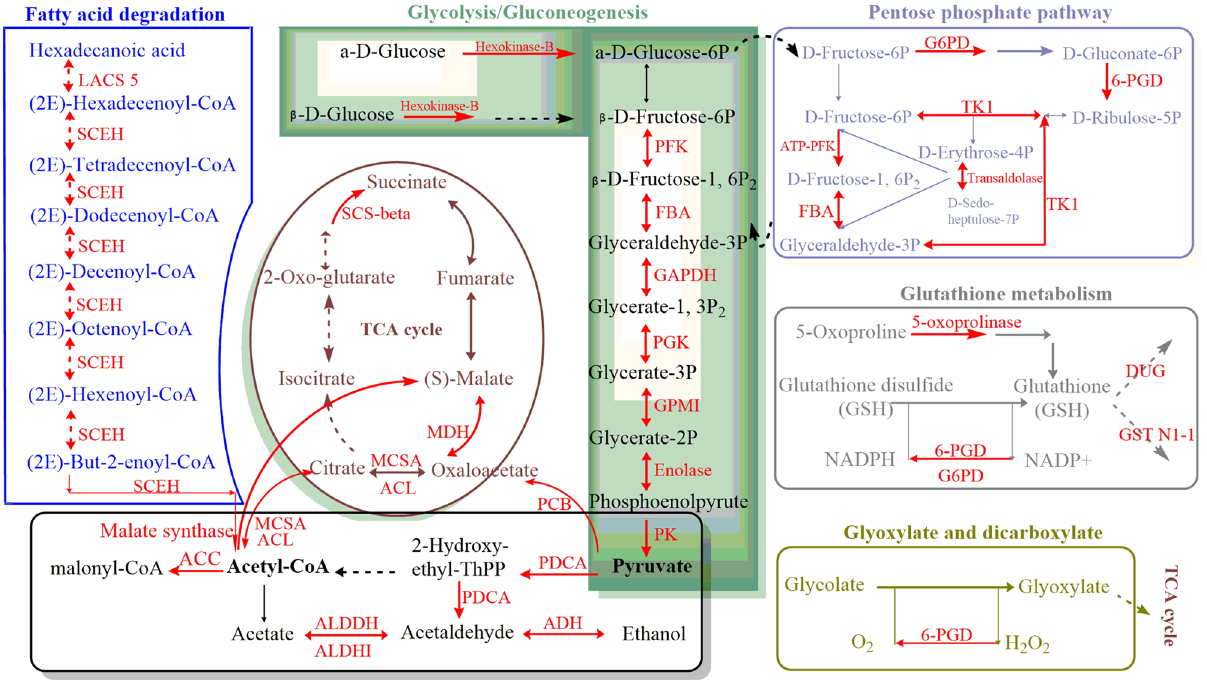
Figure 7. Quantified acetylation proteins by PRM related to the generation or elimination of reactive oxygen species in the protein–protein interaction network in P. umbellatus . Red arrows and words represent acetylated